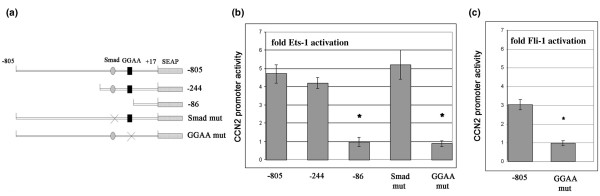
ETS family members activate the CCN2 promoter. (a) Schematic diagram of CCN2 promoter constructs used for this study: -805, construct containing -805 to +17 of the CCN promoter; -244, construct containing -244 to +17; -86, construct containing -86 to +17; Smadmut, construct containing mutated Smad element in the context of -805 to +17; GGAAmut, construct containing mutated GGAA element in the context of -805 to +17 [9,10,18,19]. Characterization of the CCN2 promoter response to (b) Ets-1 or (c) Fli-1. Different CCN2 promoter/reporter constructs, as indicated, were transfected into fibroblasts with either empty expression vector or expression vector encoding Ets-1, as described in Materials and methods. Fold increase with overexpression of (b) Ets-1 or (c) Fli-1, relative to the activity observed in the presence of empty control expression vector is shown. Average ± standard deviation (N = 6) of a representative experiment is shown (p < 0.05; asterisks indicate significantly modified by overexpression of transcription factor). Reporter activity was adjusted for differences in transfection efficiencies among samples using a control β-galactosidase expression vector.